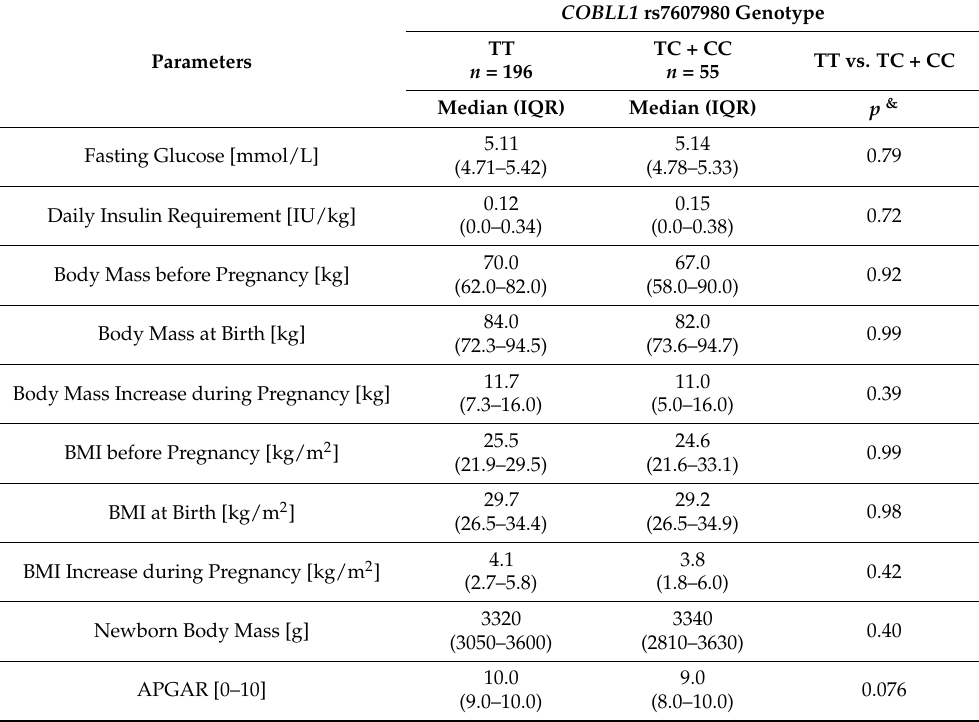
Table 2. Clinical parameters of women with GDM stratified according to COBLL1 rs7607980